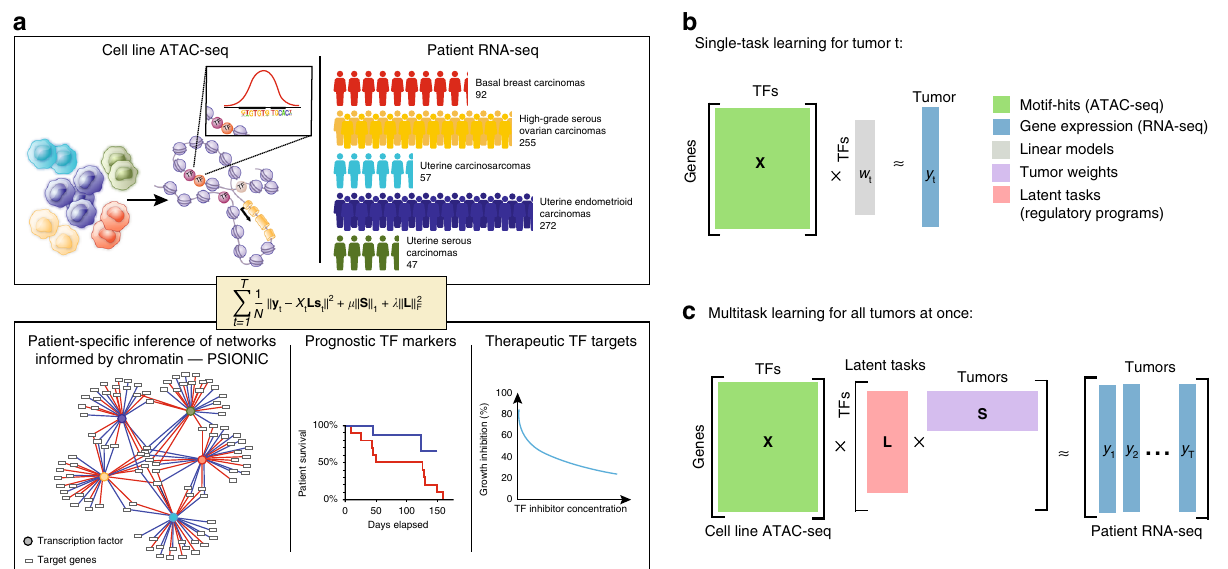
Fig. 1 Overview of PSIONIC algorithm. a The input to our framework includes assay for transposase-accessible chromatin with high-throughput sequencing (ATAC-seq) pro fi les, TF recognition motifs, and tumor expression datasets. PSIONIC integrates regulatory information for each gene based on motifs in ATAC-mapped promoters and enhancers from cancer cell lines ( X ) with RNA-seq data from patient tumors ( Y ) in order to infer patient-speci fi c TF activities ( W = LS ). Here, columns in the matrix L represent these latent regulatory programs, while S , the tumor weight matrix, captures the grouping structure and speci fi es the coef fi cients of the linear combination of latent regulatory programs for each tumor. A schematic comparison of b single task learning (STL) and c multitask learning (MTL)